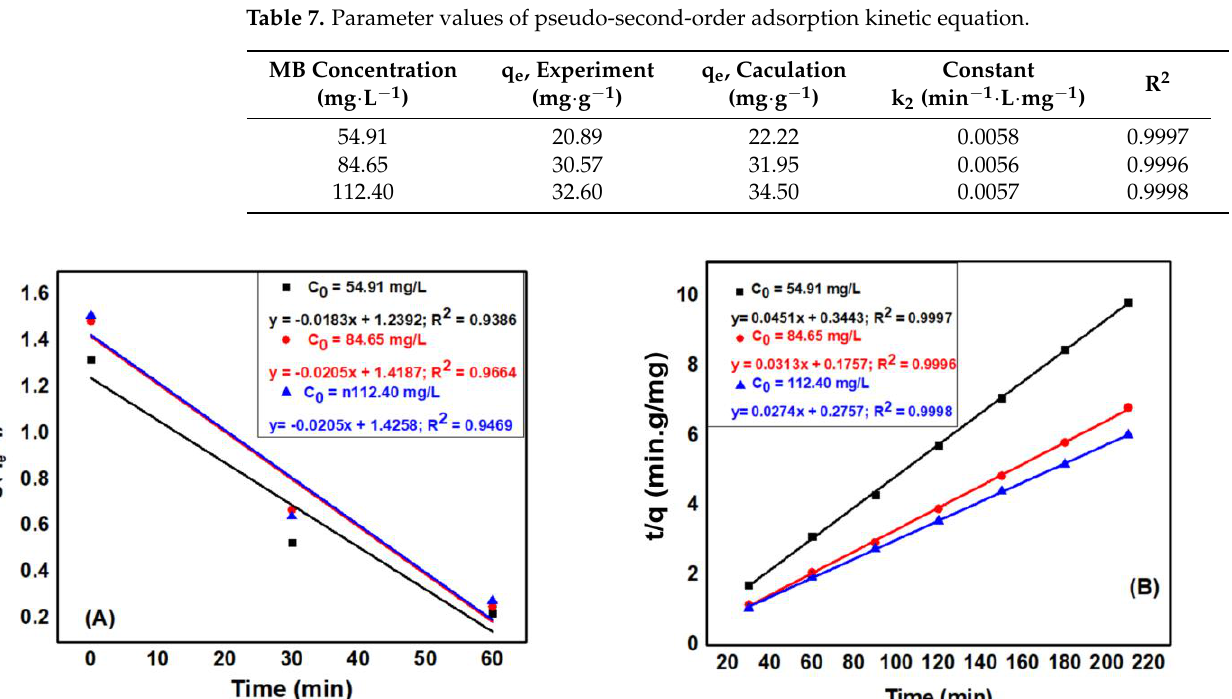
Figure 13. ( A ) The dependence of q t on time t 0.5 and ( B ) The dependence of ln(1 − F) on time. As illustrated in Figure 13B, the membrane diffusion model of the liquid Ln(1-F) is linearly dependent on time, indicating that membrane diffusion also determines the ad-